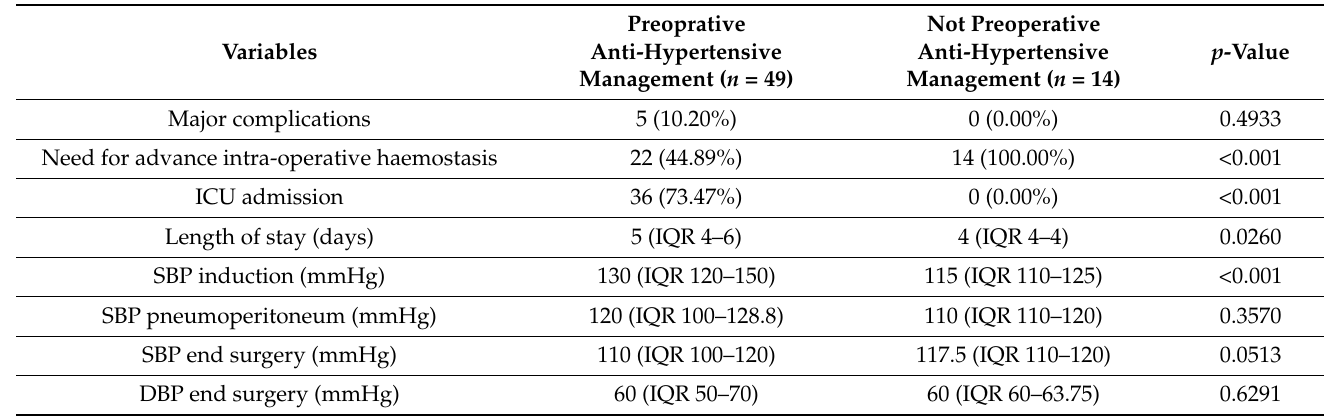
Table 2. Results of univariate